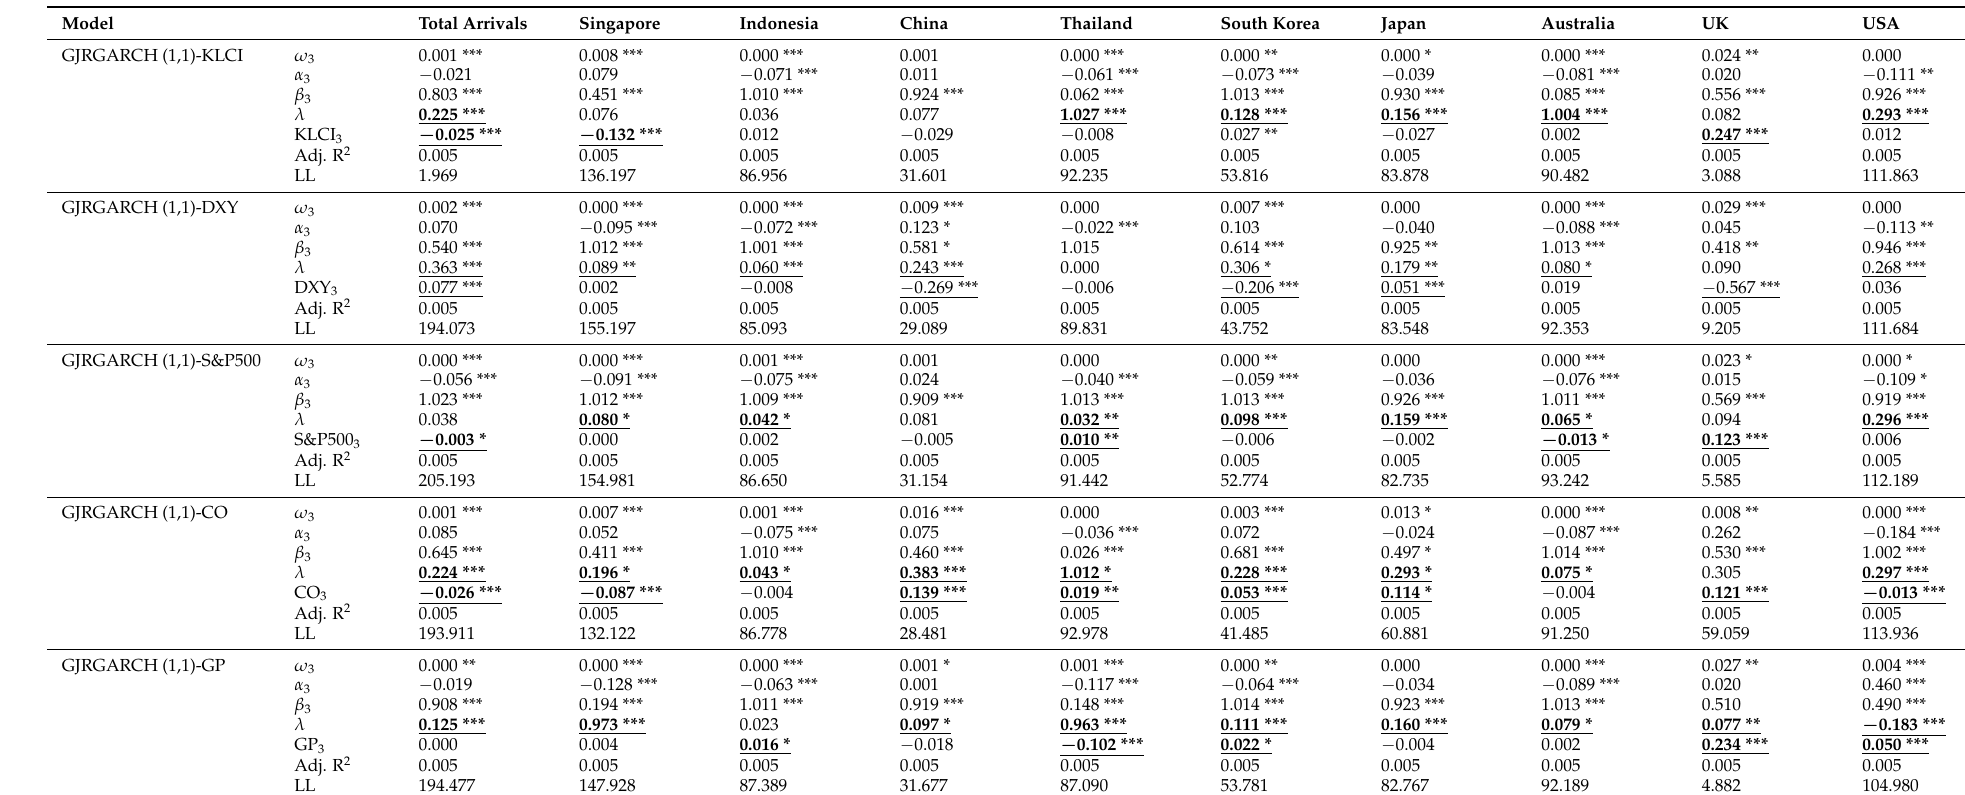
Table 9. Conditional variance equation for GJRGARCH model with financial news